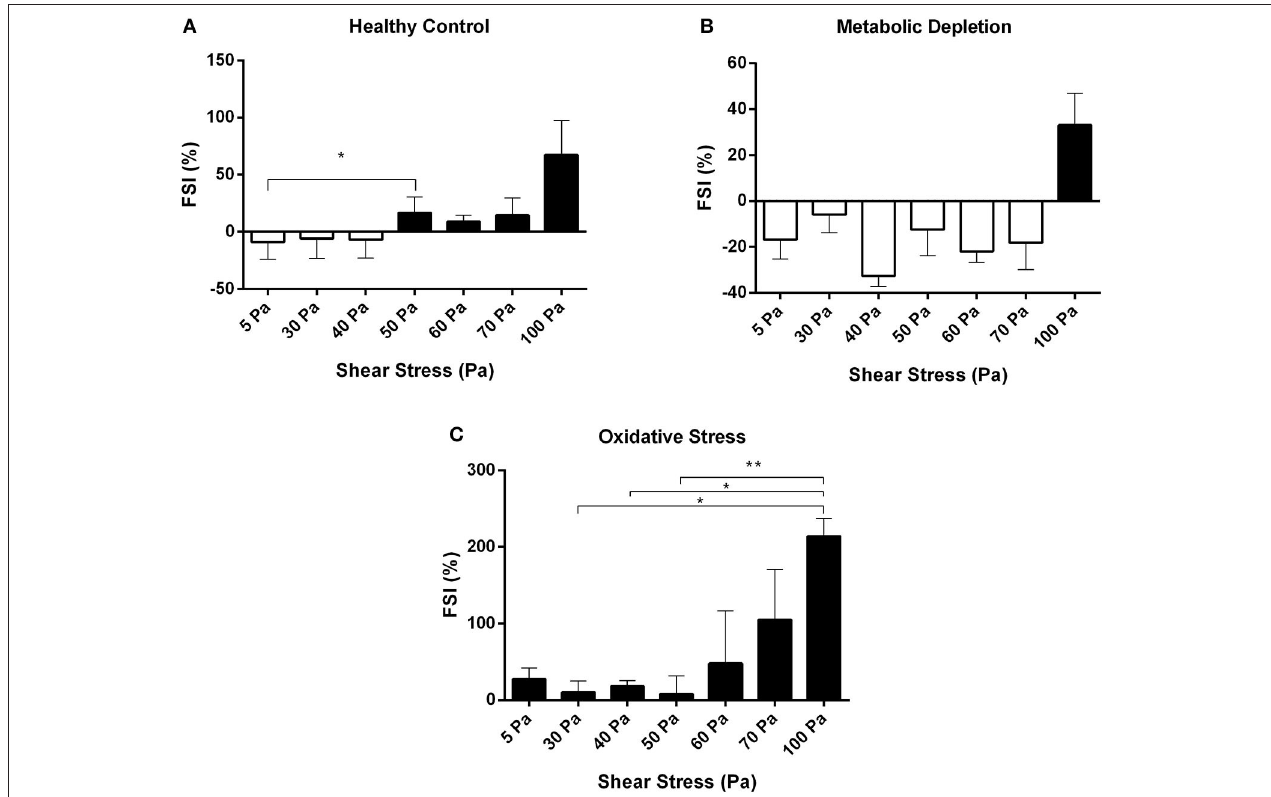
FIGURE 6 | Fragmentation sensitivity index for healthy control (A) , metabolic depletion (B) , and oxidative damage (C) groups at different levels of SS. Black bars demonstrate the sensitive RBCs for fragmentation. Data are mean ± SEM of n = 5. * p < 0.05, ** p < 0.0001 (one-way ANOVA).